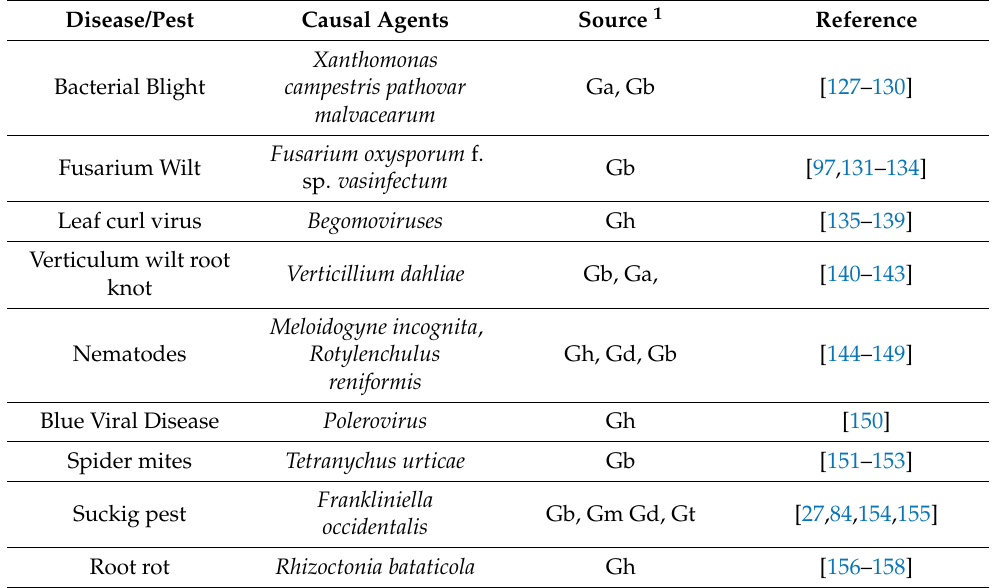
Table 3. Resistant improvements against cotton’s disease and insect pests by introgressive breeding. Disease/Pest Causal Agents Source 1 Reference Bacterial